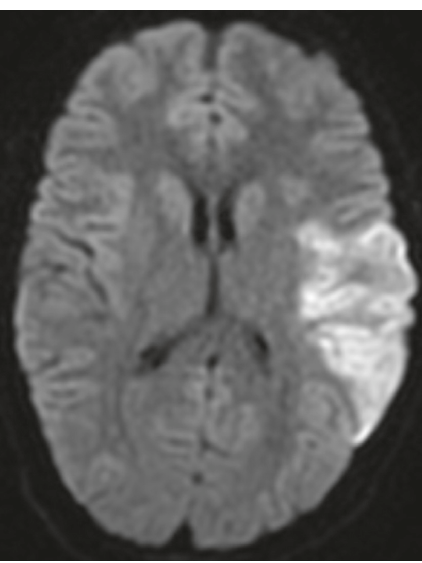
Figure 1: MRI brain without contrast (DWI—diffusion-weighted image) showing acute ischemic infarct in left temporoparietal lobe in the distribution of left MCA.